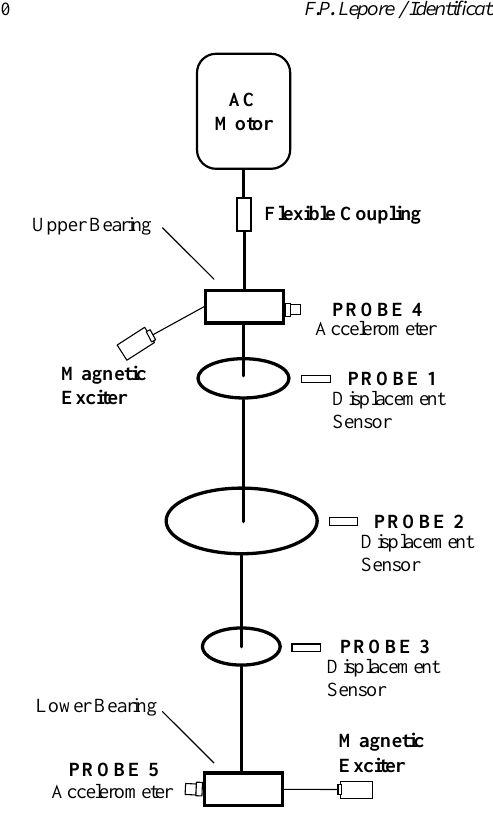
Fig. 2. Probes and exciter